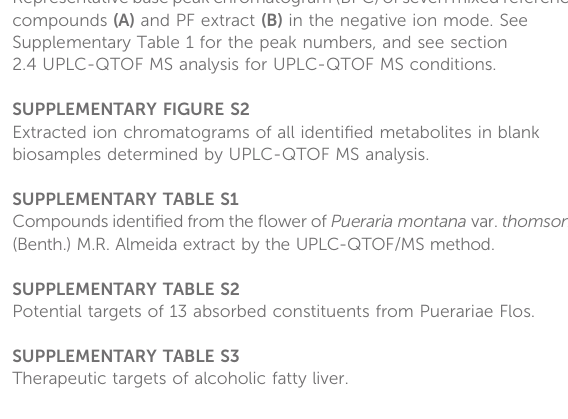
2.4 UPLC-QTOF MS analysis for UPLC-QTOF MS